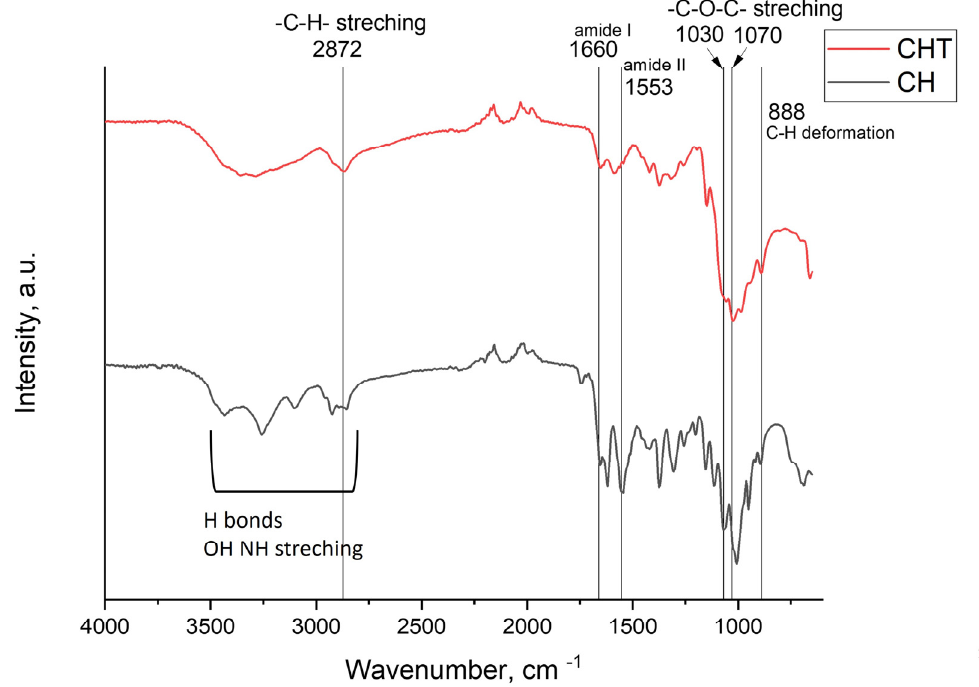
Figure 1. FTIR spectra of isolated chitin (CH) and chitosan samples (CHT).